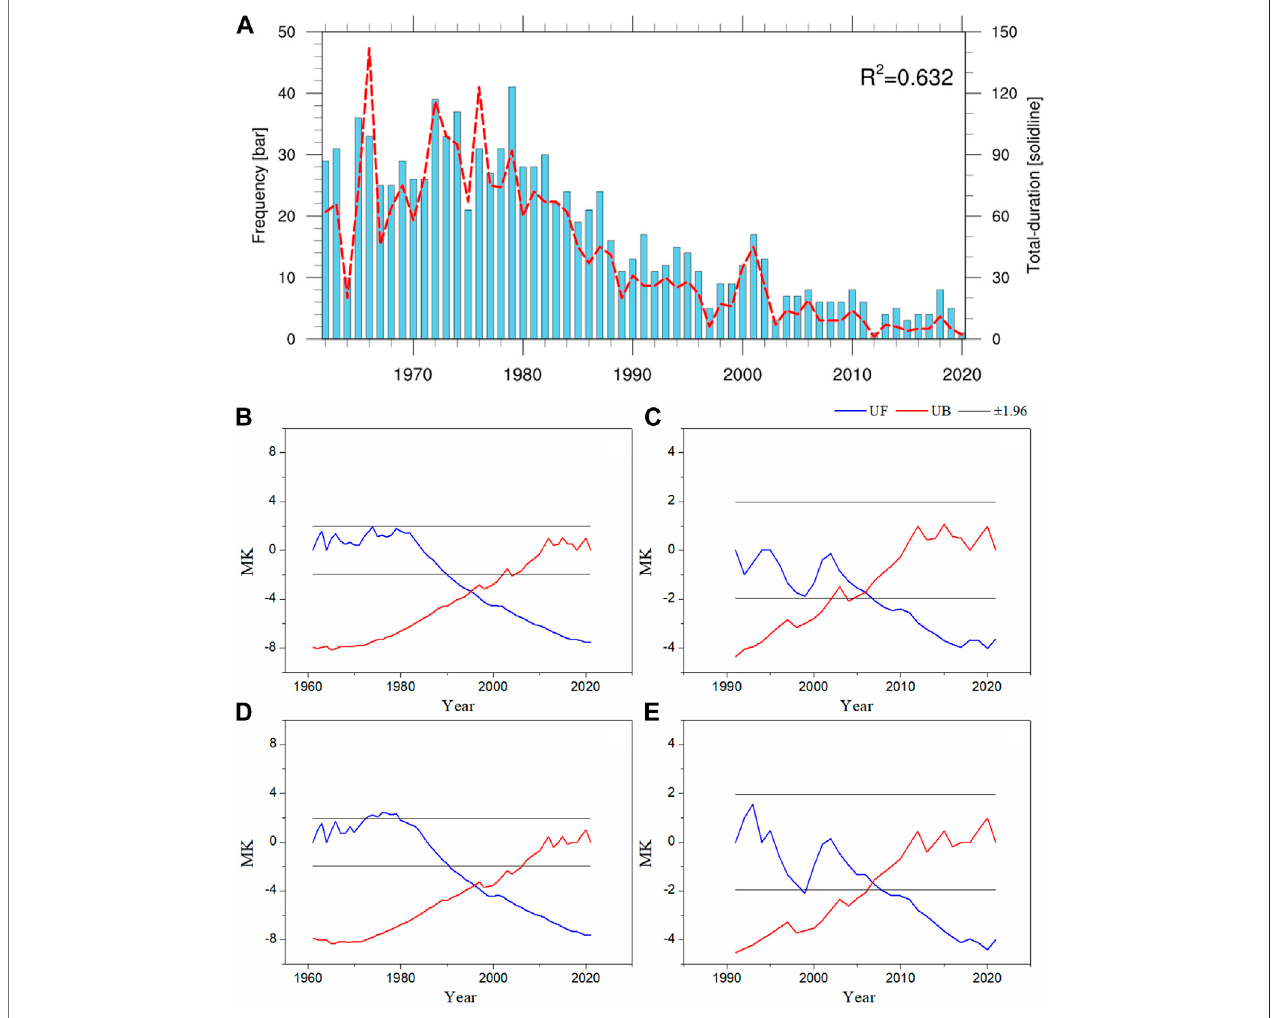
FIGURE2 |(A) Annual total frequency (blue histogram) and total days (red solidline; unit: day) ofsand-dust processes. Test results of (B,C) annual total frequency and (D,E) annual total days of sand-dust processes during 1961 – 2020 by the MK. The blue line represents UF in the MK method, the red line represents UB, and the black line is ±1.96 (0.05 signi fi cance). (B) and (D) are the detection of the 1961 – 2020 sequence, and (C) and (E) are the detection of the 1991 – 2020